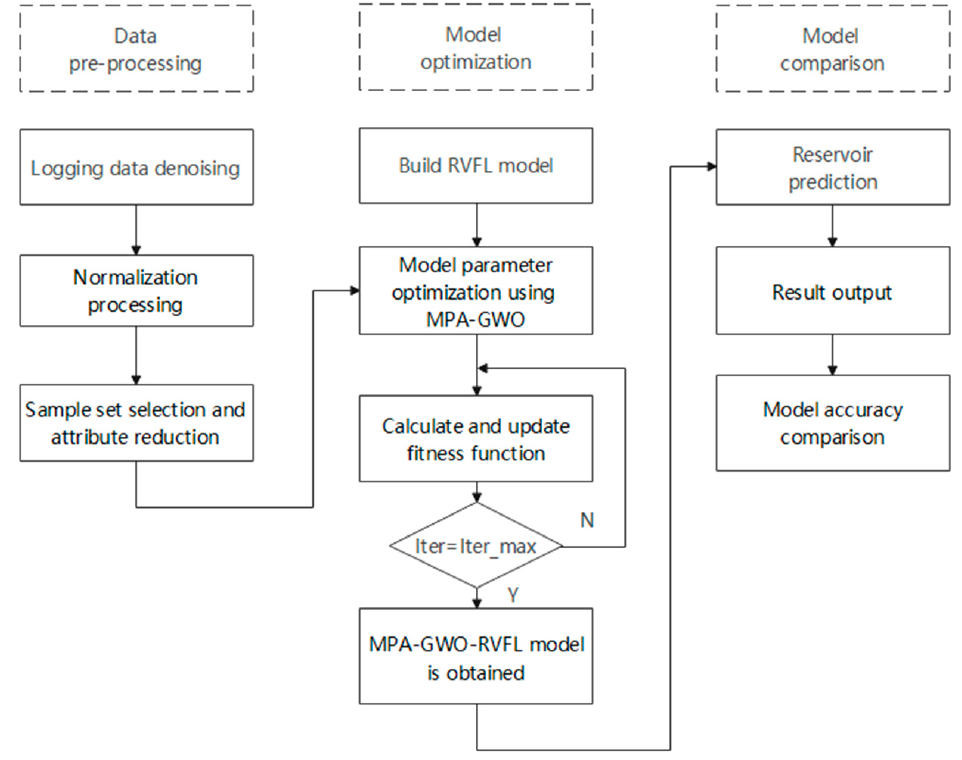
Figure 3. Block diagram of the MPA-GWO-RVFL-based Oil layer prediction system.